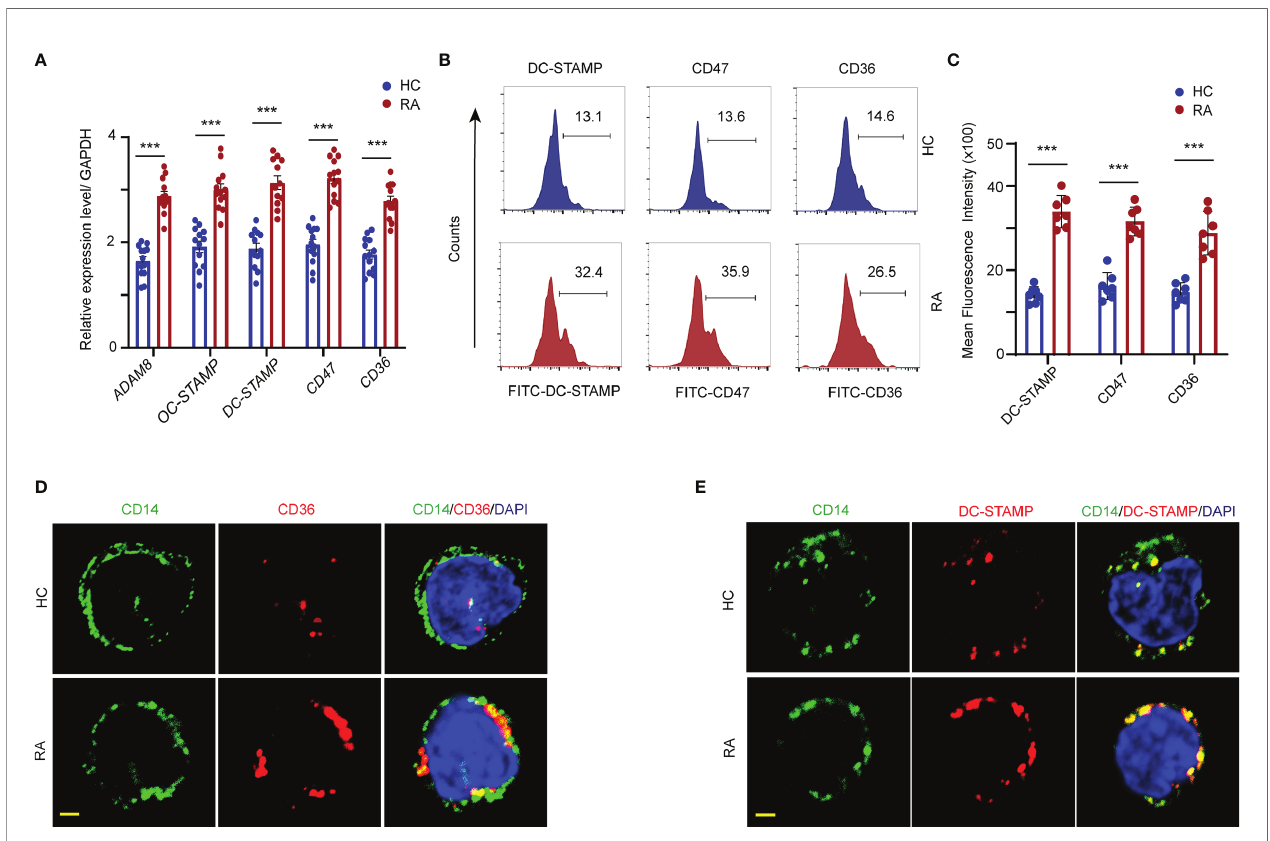
FIGURE 3 | FAO promotes fusogenic molecular expression in the cellular membrane. CD14 + monocytes were isolated from RA patients and controls. (A) Transcript levels of ADAM8 , OC-STAMP , DC-STAMP , CD47 , and CD36 were quanti fi ed by qPCR from RA patients and HCs. The results from 3 independent experiments. (B, C) The DC-STAMP, CD47, CD36 membrane expression level in monocytes were analyzed by fl ow cytometry. Representative histograms for one HC (blue) and one RA (red); three independent experiments examining 6 HCs and 7 RA patients are presented as the mean ± SEM. (D, E) Localization of DC-STAMP and CD36 in the cellular membrane of monocytes were detected by immuno fl uorescence staining. Bar 10 m m. All data shown as the mean ± SEM. *** P <